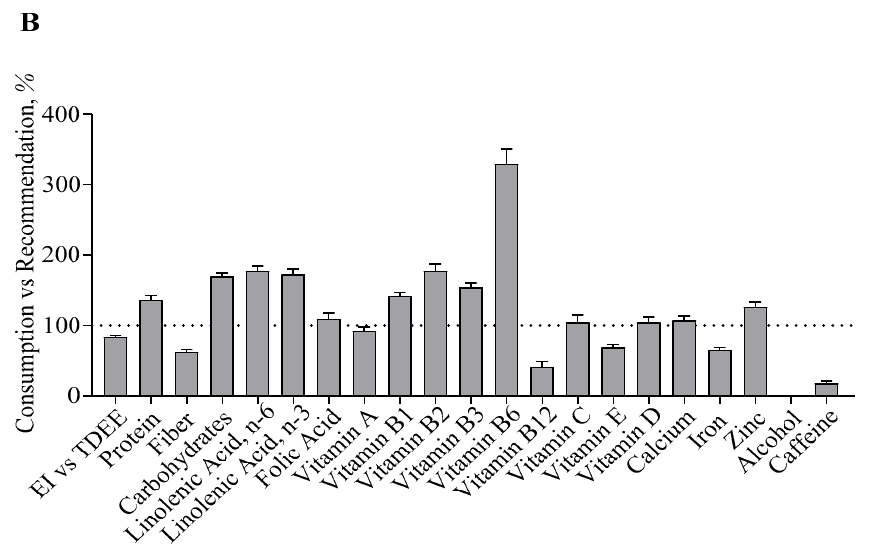
Figure 1. Diet Quality per Healthy Eating Index Components, and Recommendations for Intakes of Macronutrients and Micronutrients. Data are given as mean and mean ± SEM. ( A ) Values in the dark grey area indicate the respective Healthy Eating Index (HEI) food group to be consumed “poorly” (0–5), values in the light grey area as “needs improvement” (5–8) and in the white area as “sufficient” (8–10), according to the HEI guidelines [25]. HEI components scaled from 0–10 are reported as assessed and components scaled 0–5 were multiplied by two to facilitate comparability between factors. ( B ) Values are expressed as intake as compared to the minimal macronutrient and micronutrient intake recommendation by the WHO (maximum intake recommendation for alcohol and caffeine). Macronutrient and Micronutrient intake values are adjusted for the degree of underreporting per individual ( − 16 ± 2% vs TDEE, adjusted intake=reported intake/reporting accuracy [“EI vs TDEE”]).